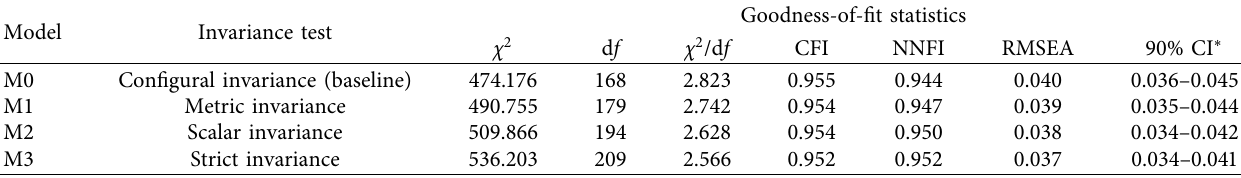
Table 10: Goodness-of-fit statistics for multisample structural equation models (male versus female). Model